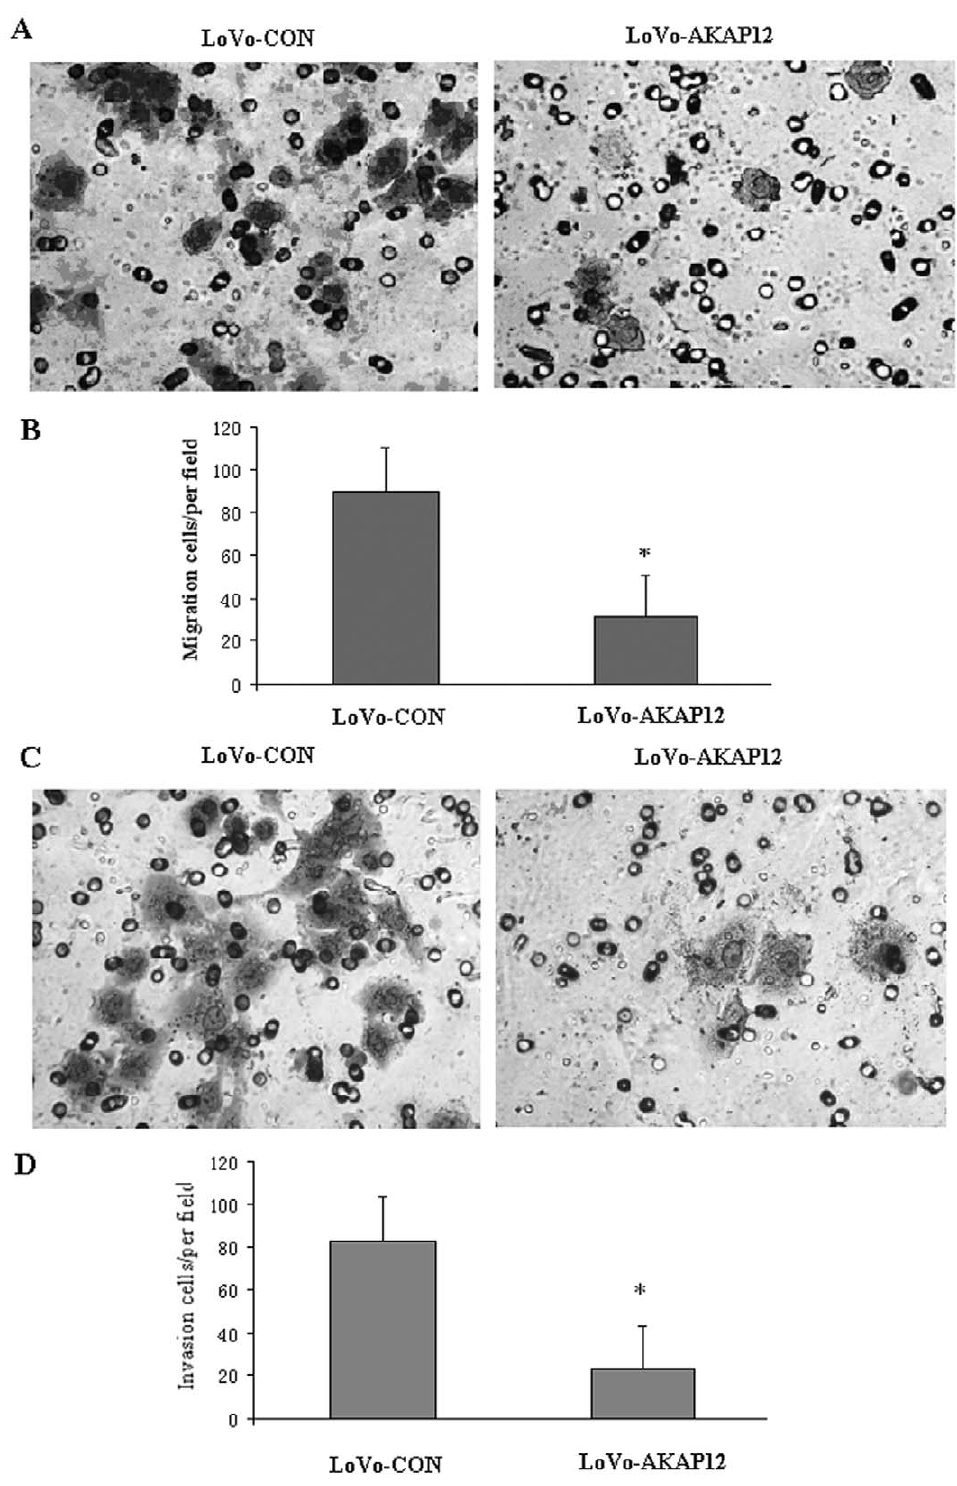
Figure 2. AKAKP12 suppresses invitro migration and invasion ability of LoVo cells. (A) LoVo-AKAP12 and LoVo-CON cells penetrated through the transwell chambers and were photographed at 6 100 magnification. (B) The in vitro migration ability of LoVo-AKAP12 cells and LoVo- CON cells was measured by determining the number of cells that migrated through the transwell chamber. Columns, mean values; bar, SD. * p , 0.01. (C) LoVo-AKAP12 and LoVo-CON cells that migrated through the transwell chambers and photographed at 6 100 magnification. (D) The in vitro migration ability of LoVo-AKAP12 cells and LoVo-CON cells was measured by determining the number of matrigel-coated cells that penetrated through the transwell chambers. Columns, mean values; bar, SD. * p , 0.01.